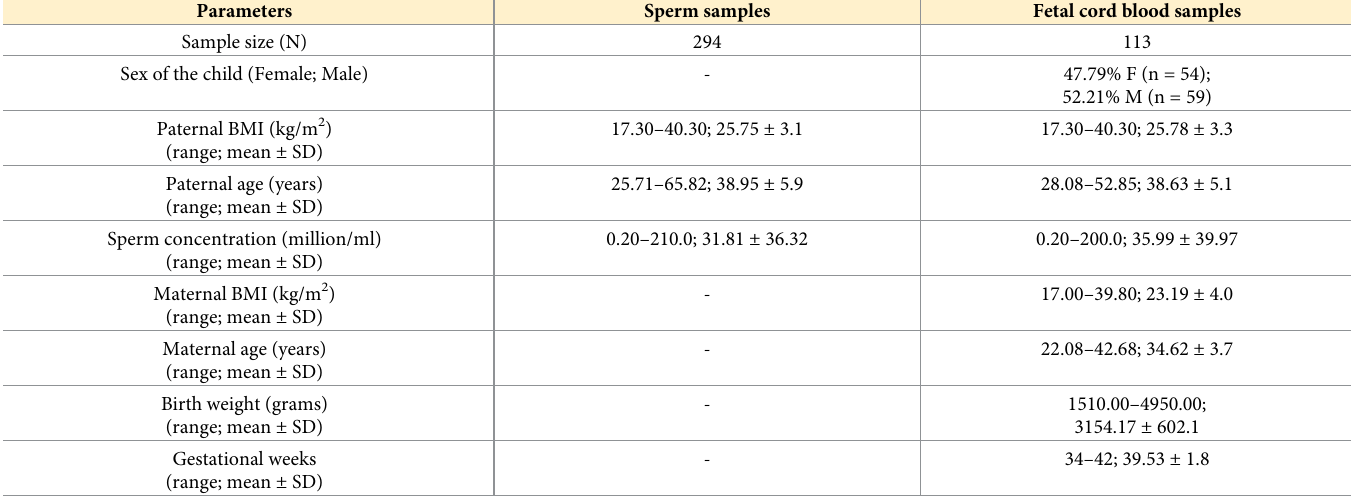
Table 1. Clinical parameters of the sperm and fetal cord blood samples. Parameters Sperm samples Fetal cord blood